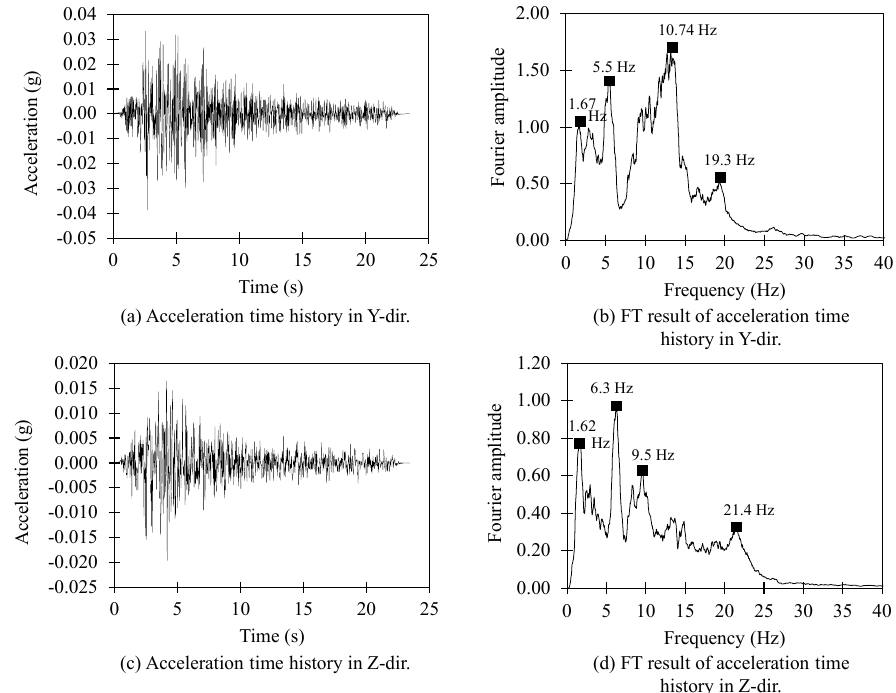
Figure 18. Characteristics of Friuli_Italy-01 earthquake (Y and Z-directions).